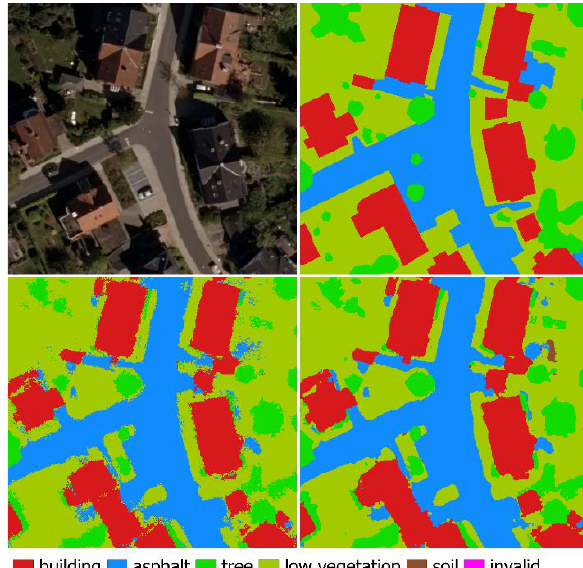
Figure 3 : Classification results. Top left: input image; top right: reference labels; bottom left: results of RF-STD; bottom right: results of CRF.